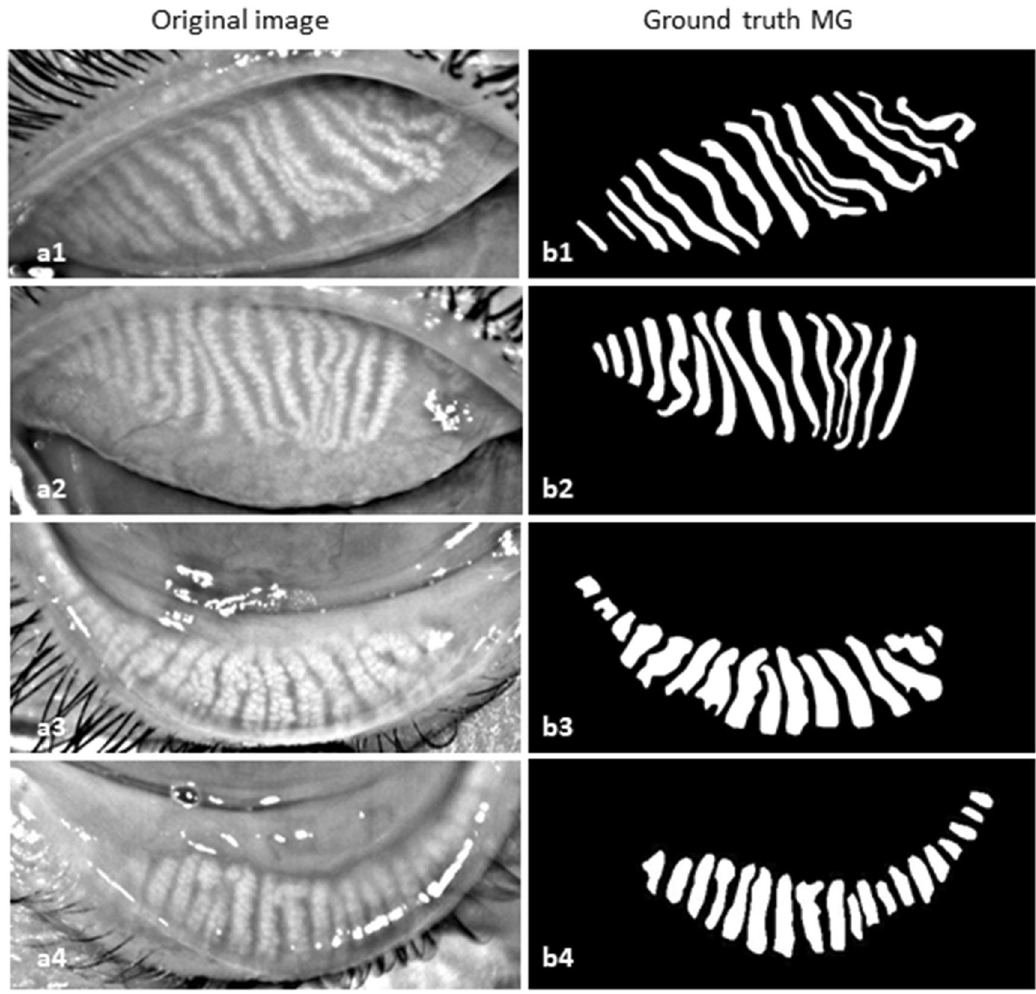
Figure 1. Example of training images and their corresponding ground truth images. ( a1–a2 ) anonymized upper eyelid images, ( a3–a4 ) anonymized lower eyelid images, ( b1–b2 ) upper eyelid ground truth images, and ( b3–b4 ) lower eyelid ground truth